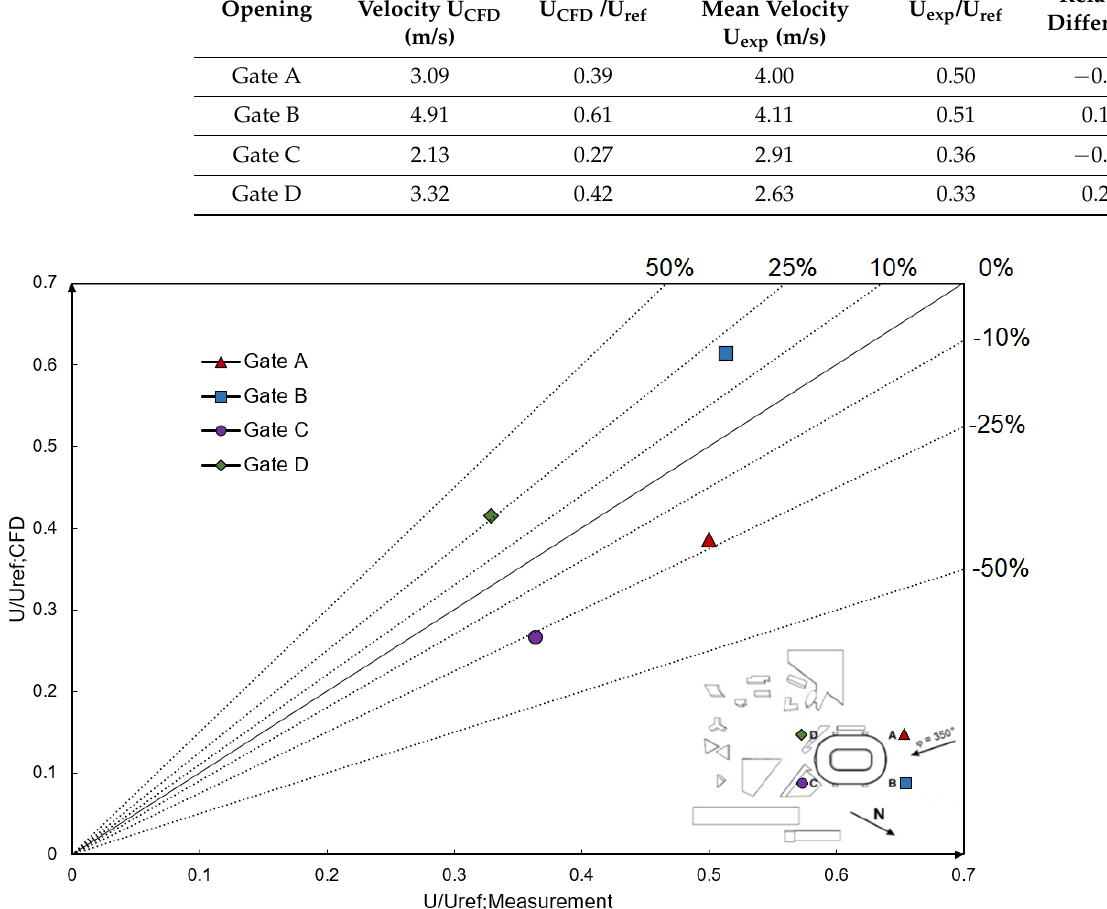
Table 5. Wind velocity validation results for the CFD model in the wind direction of 350°. Opening